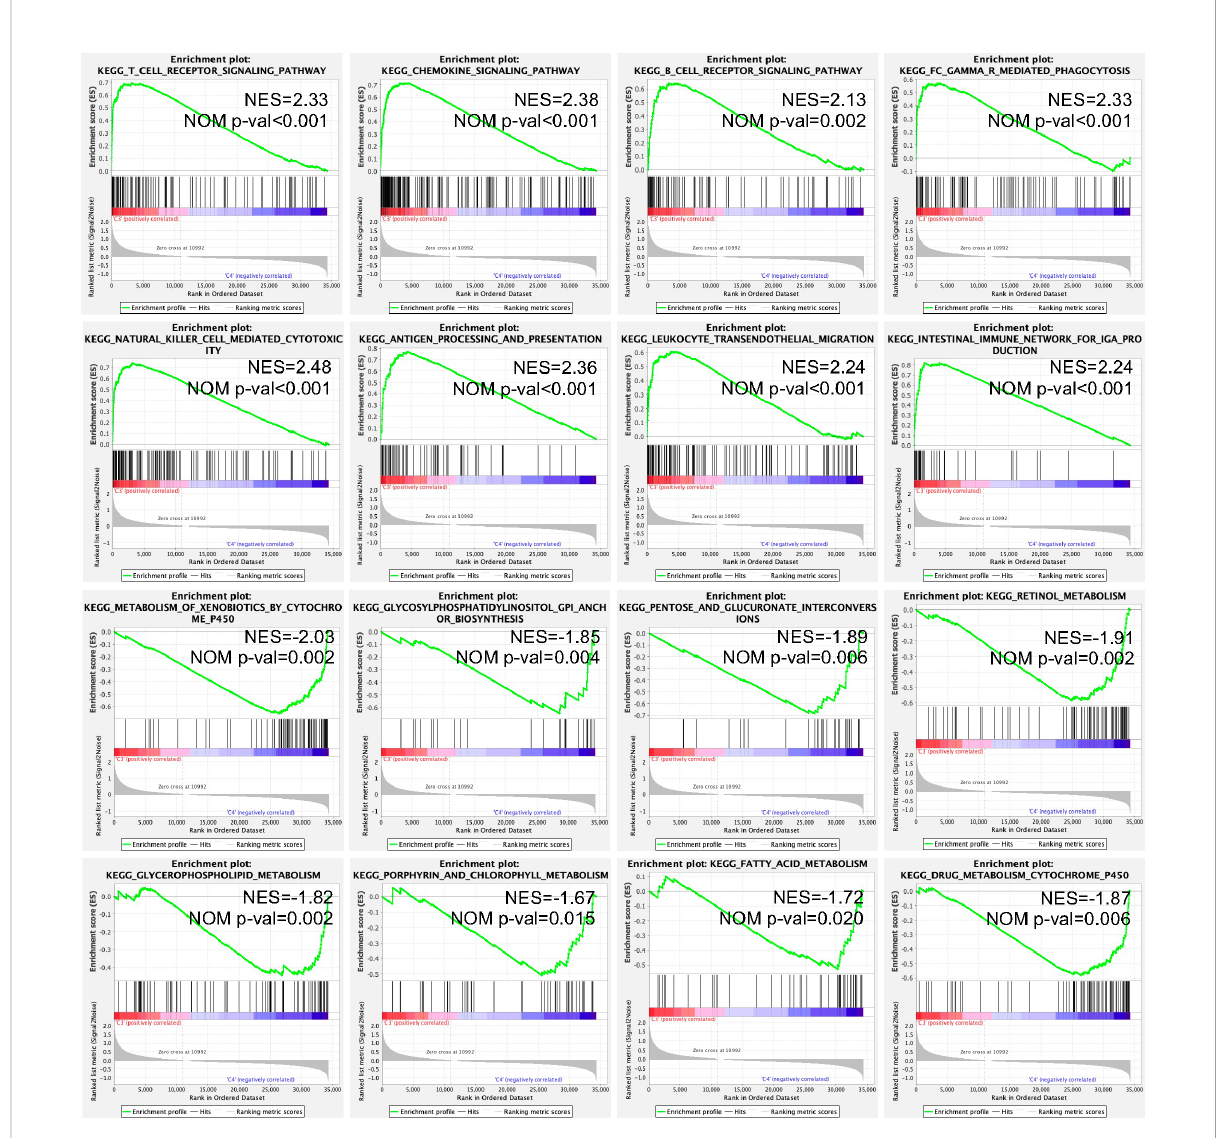
FIGURE 5 Enriched KEGG signaling pathways in the C3 and C4 immune subtypes using the GSEA method. NES, normalized enrichment score; NOM P-val, nominal p value; KEGG, Kyoto Encyclopedia of Genes and Genomes; and GSEA, Gene Set Enrichment